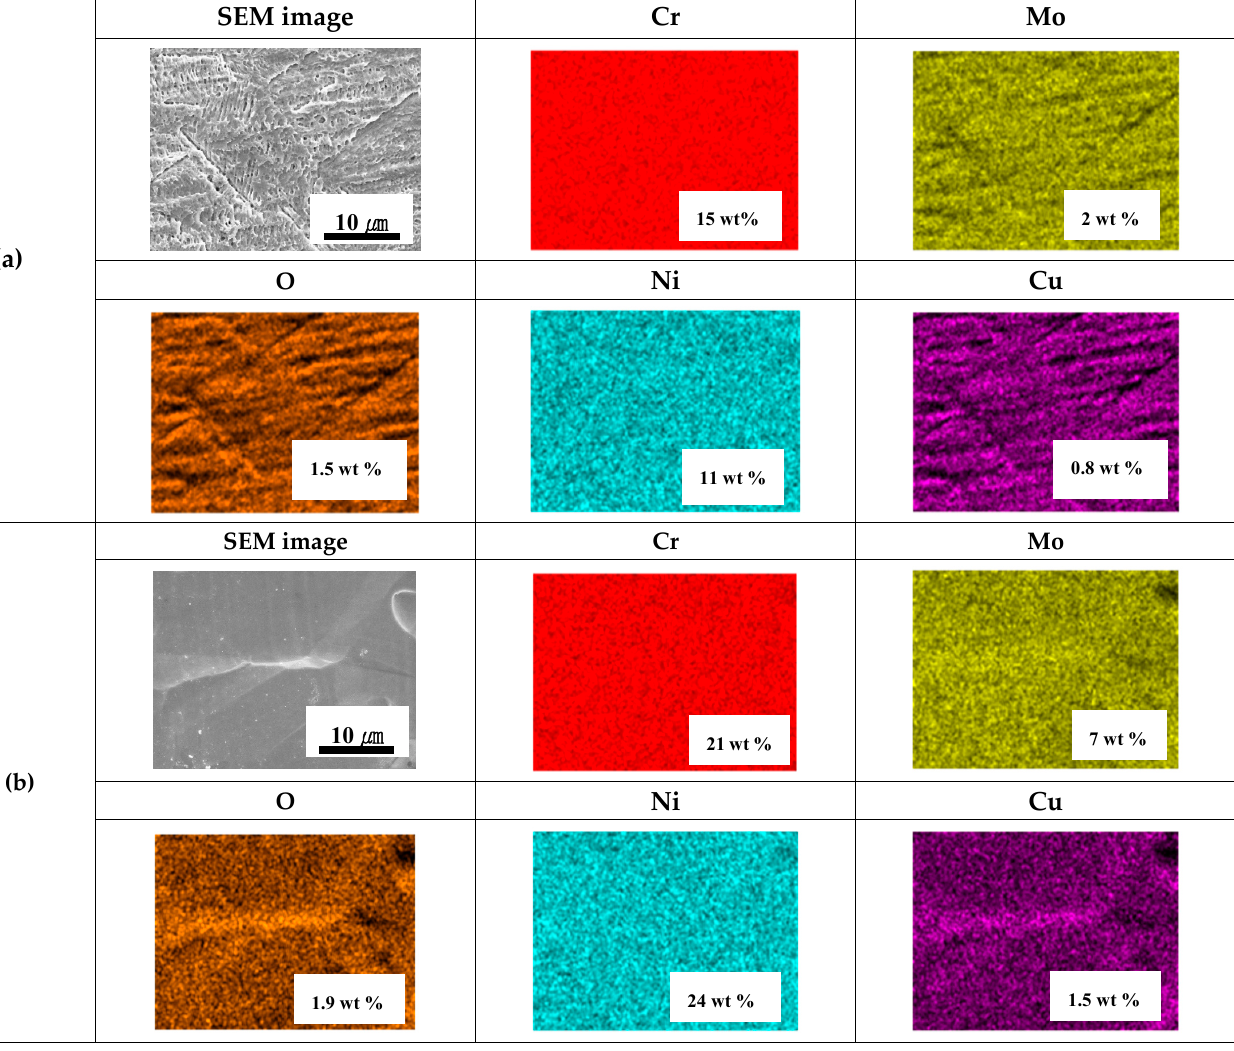
Figure 3. EDS analysis of UNS S31603 and UNS N08367 after potentiodynamic polarization experi- ment in modified green death solution at 60 ◦ C ( a ): UNS S31603 ( b ): UNS N083637.